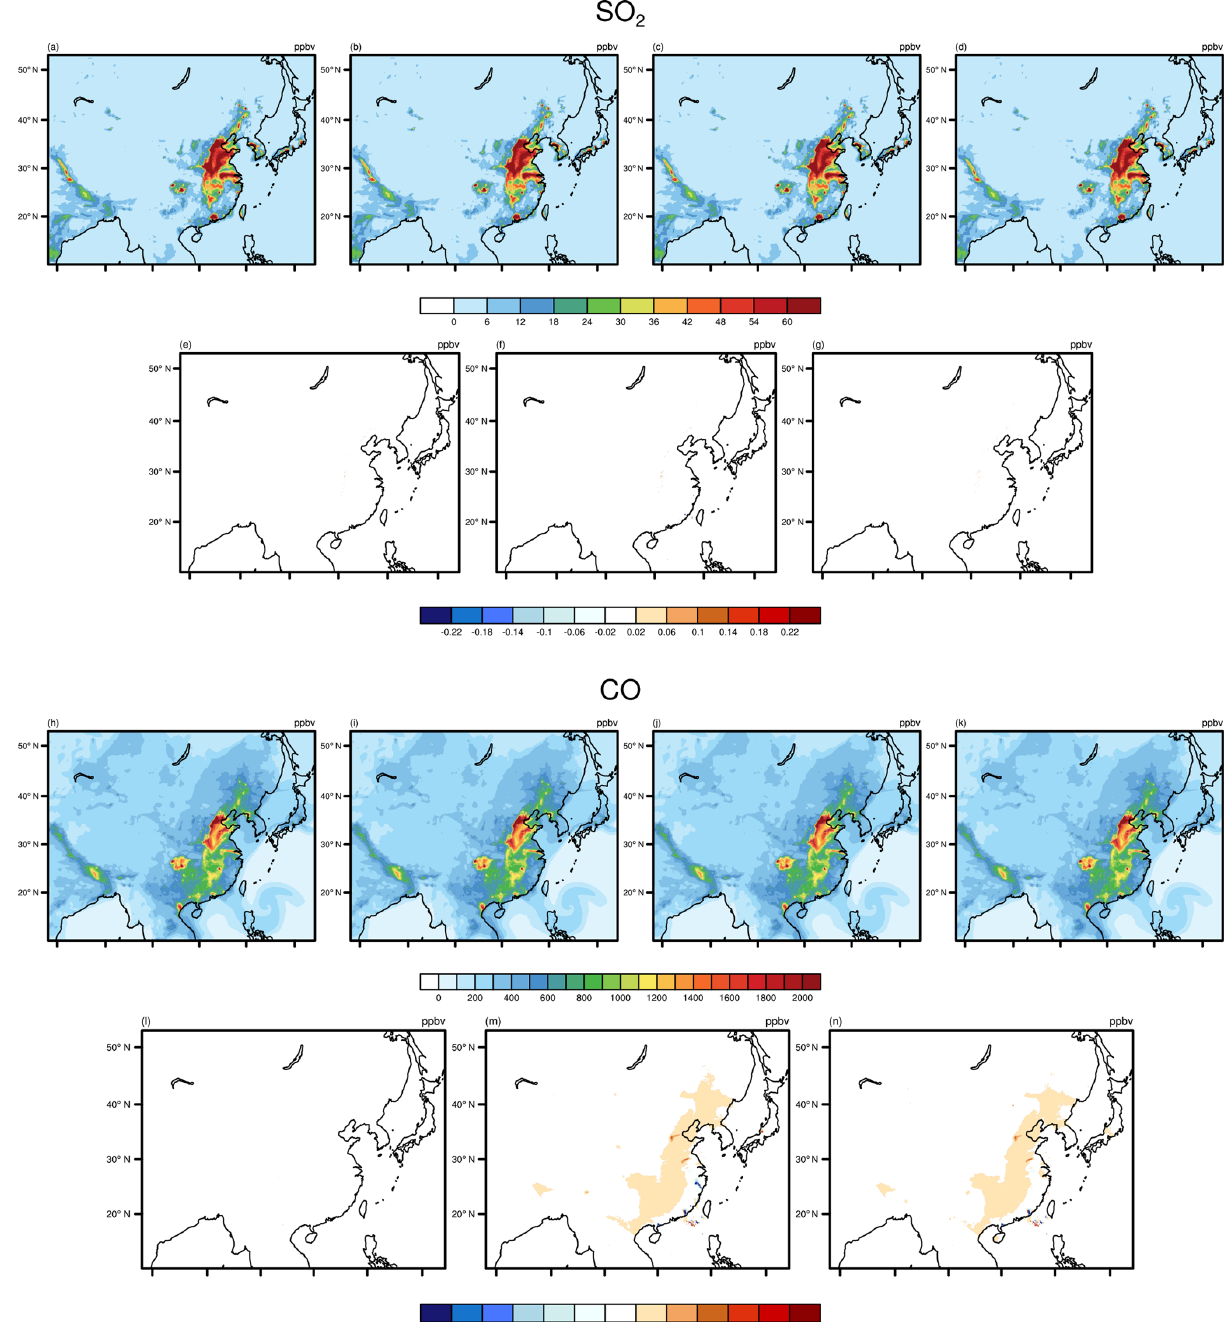
Figure 6. SO 2 and CO concentrations outputted by baseline and optimized code with different accuracy compile flags. Panels (a) and (h) are from baselines code compiled by the precise option, which are treated as benchmark for comparison. Panels (b) and (i) are from optimized code compiled by the precise option. Panels (c) and (j) are from baseline codes compiled by the fast = 1 flag. Panels (d) and (k) are from optimized code compiled by the fast = 1 flag. Panels (e–g) and (l–m) are the output concentration differences of optimized code (precise), baseline code (fast = 1), and optimized code (fast = 1) compared with baseline code